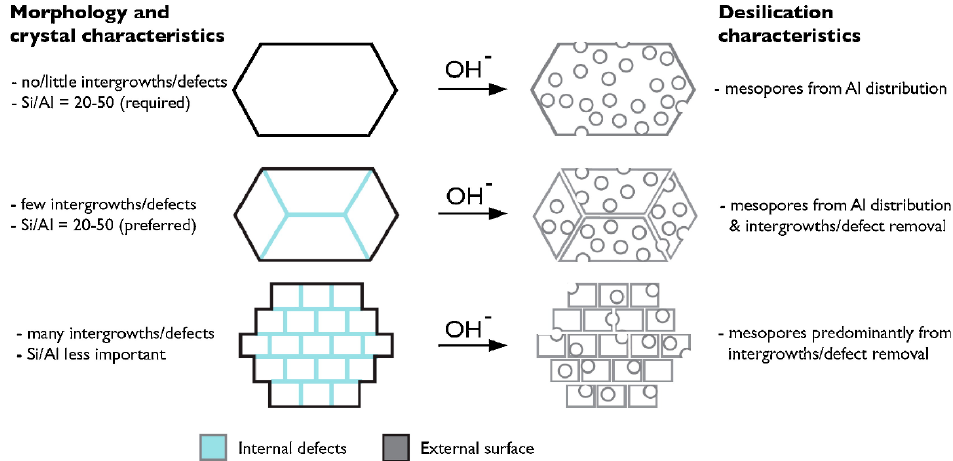
Figure 10. Schematic representation of different mechanisms of idealized mesopore formation [107]. Copyright (2011), with permission from Elsevier.